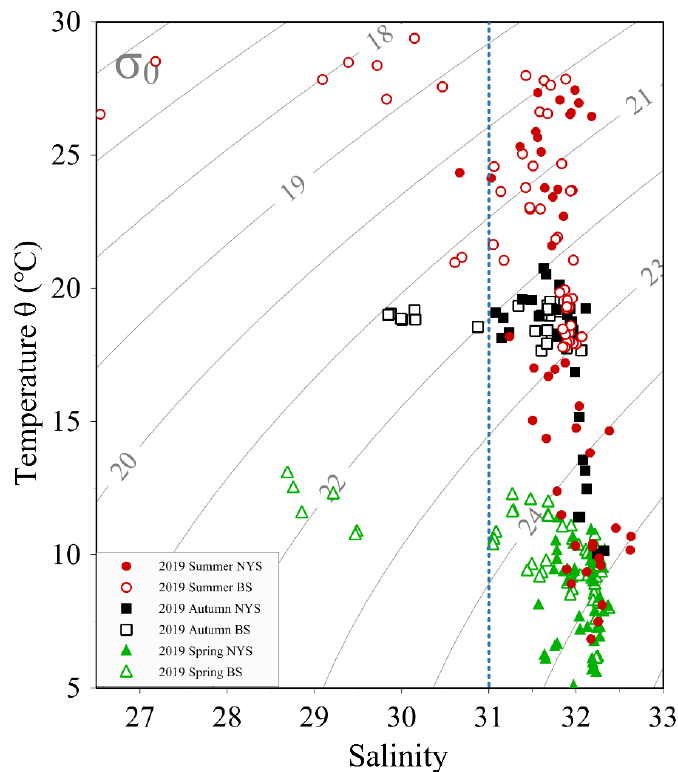
Figure 2. Temperature-salinity (T-S) relationship of sea water during three cruises (spring, summer, autumn) in the BS and NYS. A salinity of ~31 psu characterizes the coastal water system (dashed blue line), and x-axis is salinity, y-axis is temperature, and the isobars are density. NYS is the north Yellow Sea and BS is the Bohai Sea.